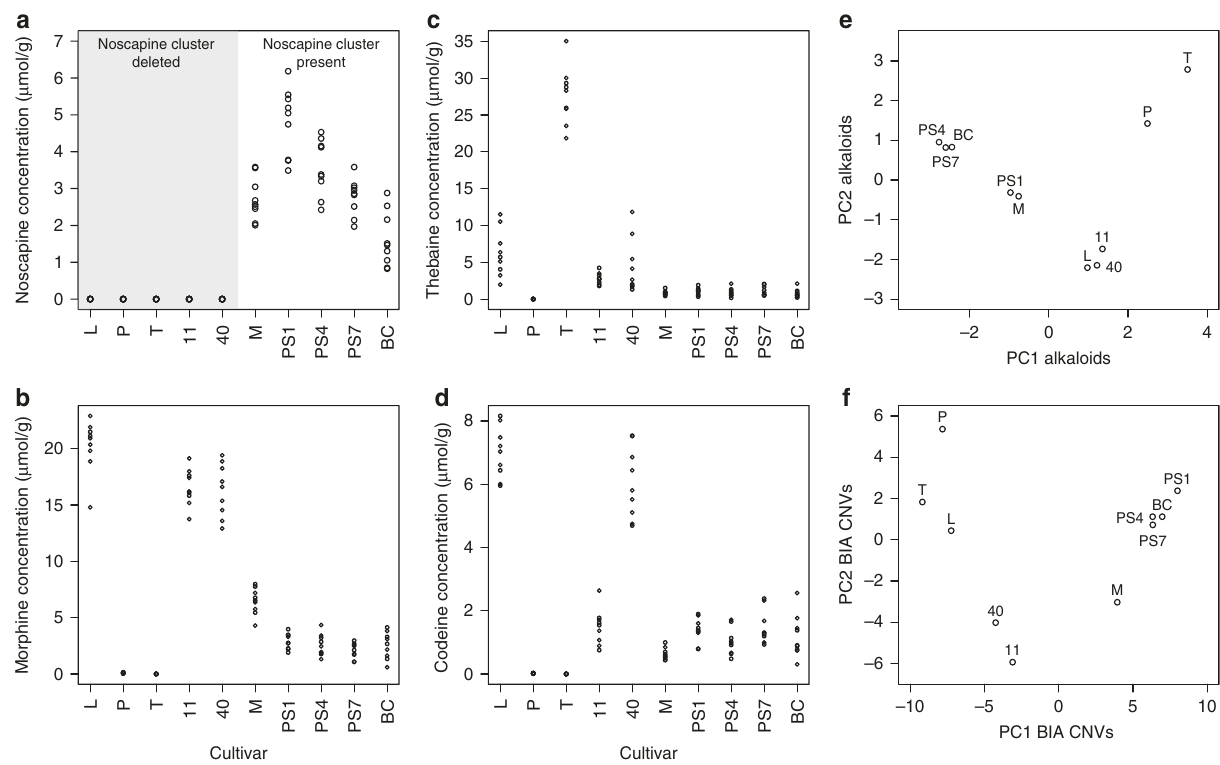
Fig. 6 Alkaloid production and copy number variation of pathway genes in opium poppy. Alkaloid content measured in stem tissues of nine replicate plants from each of the ten sequenced cultivars for noscapine ( a ), morphine ( b ), thebaine ( c ), and codeine ( d ). Principal Components Analysis reveals strong similarities between cultivars in their pro fi les of alkaloid production ( e ) and copy number variation ( f ). Source data are provided as a Source Data fi